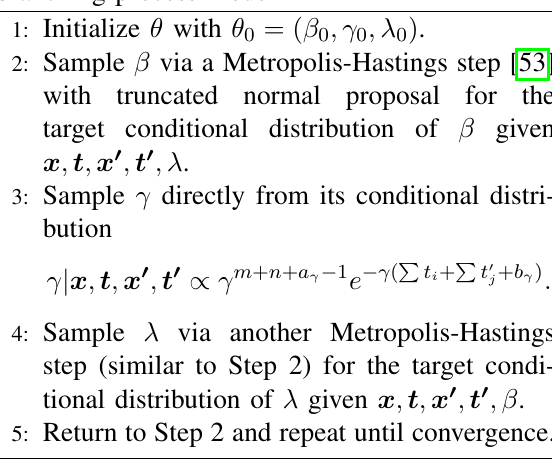
Algorithm 1 MCMC posterior sampler for the branching process